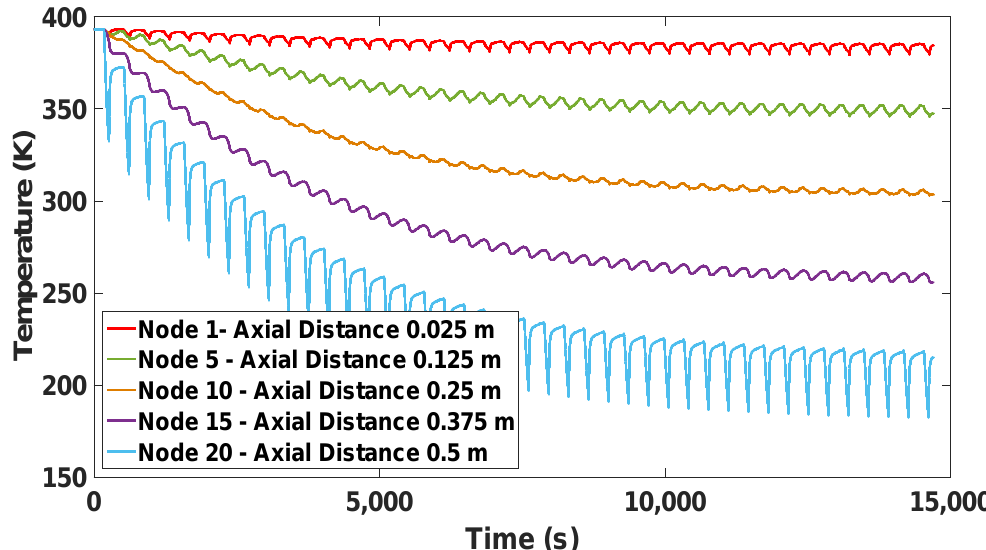
Figure 10. Solid temperature profile from start-up to CSS.